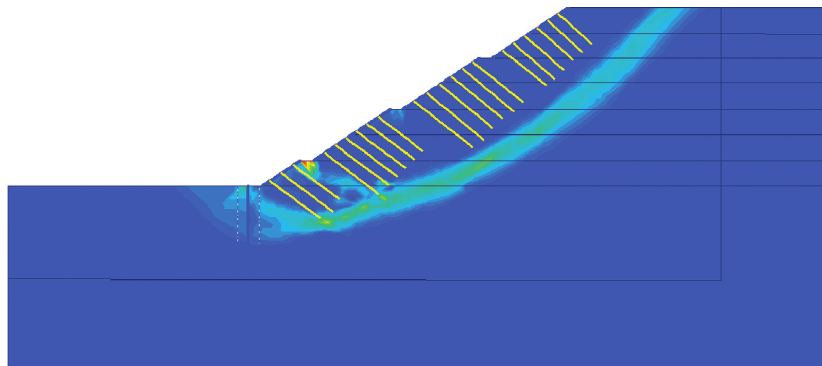
Figure 11: Shear strain increment nephogram of reinforced slope working condition 8 after strength